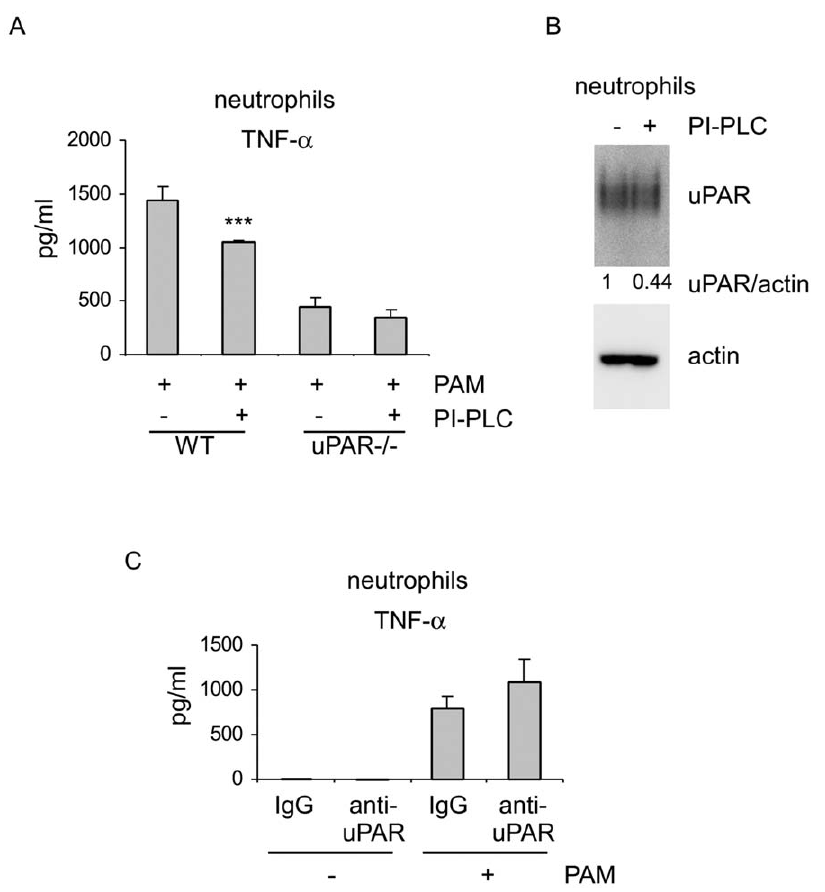
Figure 2. uPAR cleavage by PI-PLC attenuates neutrophil activation upon TLR2 stimulation. (A) 2 6 10 6 WT and uPAR-/- neutrophils were pre-treated without or with 1 U/ml PI-PLC for 1.5 hours. The cells were then collected by centrifugation, washed twice with PBS, and treated with 1 m g/ml PAM for 4 hours. The supernatants were collected and the levels of TNF- a determined. n=3 for each condition; Mean 6 SD; ***p , 0.001 when compared to WT neutrophils pretreated without PI-PLC. One representative experiment is shown. A second independent experiment provided similar results. (B) Experiments were performed as in A. Levels of uPAR and actin were determined by Western blotting. Densitometric analysis was performed, and the ratios of uPAR/actin calculated. The uPAR/actin ratio in untreated group was considered to be 1. The values in PI-PLC treated cells are shown as the ratio to that of the untreated group. Representative blots from two independent experiments are shown. (C) 2 6 10 6 WT neutrophils were pre-treated with 5 m g/ml control IgG or anti-uPAR antibodies for 1 hour. The cells were then collected by centrifugation, washed twice with PBS, and treated without or with 1 m g/ml PAM for 4 hours. The supernatants were collected and the levels of TNF- a determined.